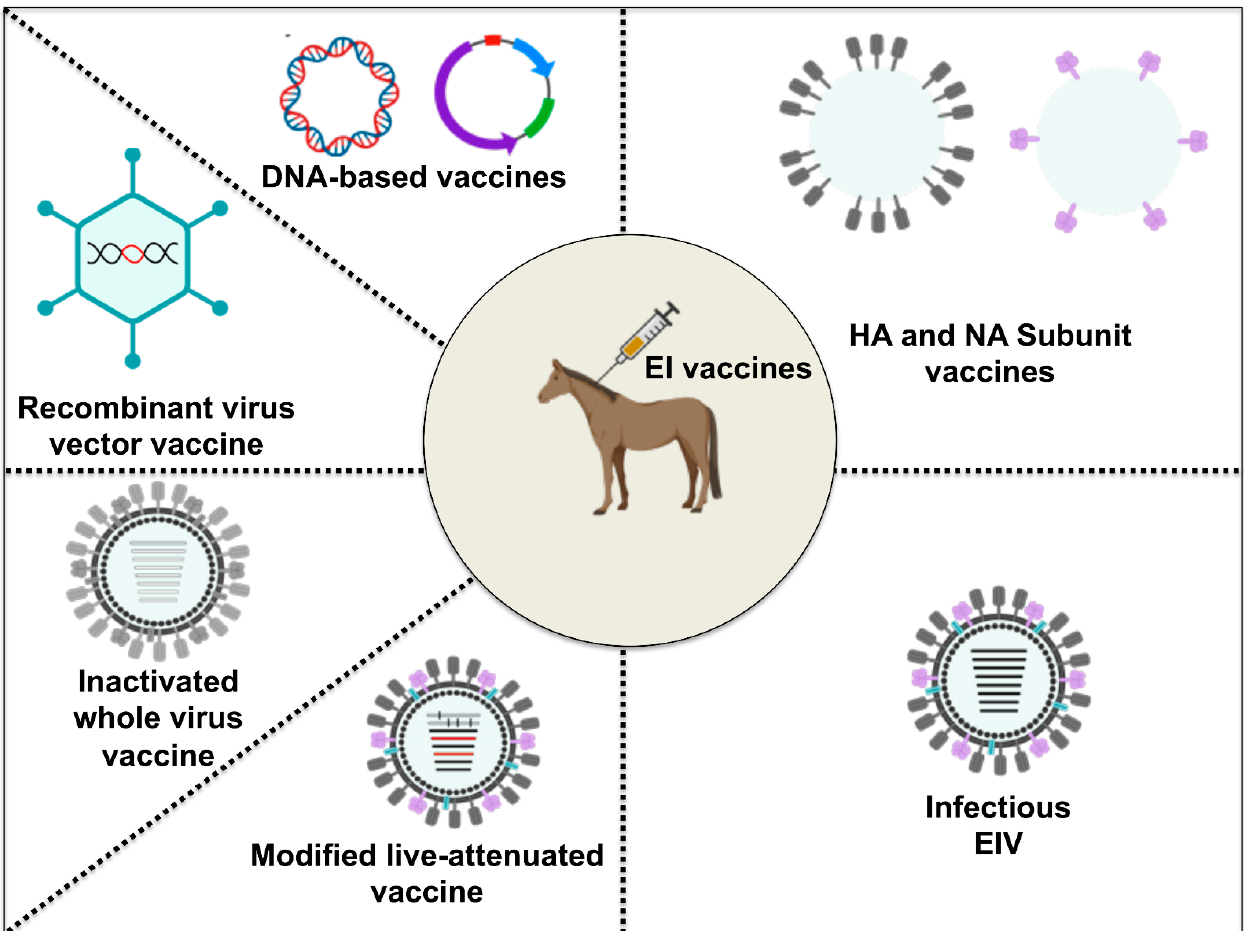
Figure 5. EI vaccine technologies: Each EI vaccine system differs in its antigenic composition and structural organization. These differences impact on the immunogenicity of the vaccine type.